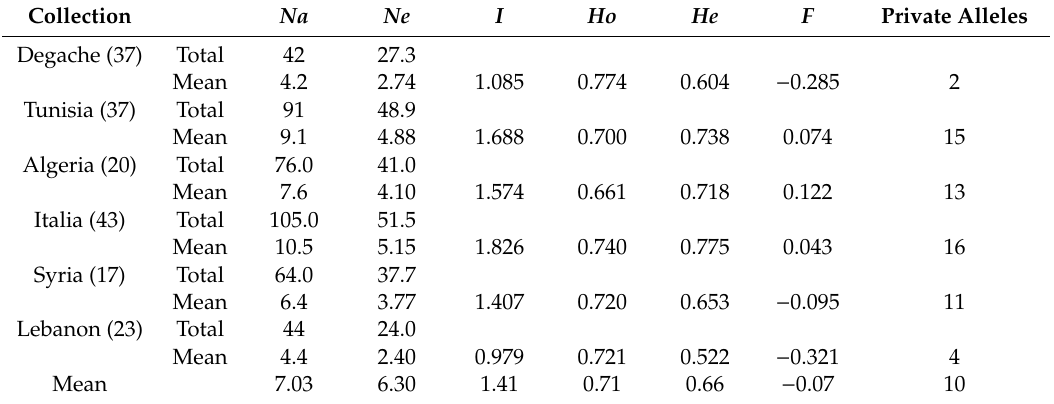
Table 2. Genetic diversity indices Na, Ne, I, Ho, He, F and private Alleles obtained with 10 SSR markers in the 6 groups of genotypes of di ff erent geographical origin (number of samples in parentheses).